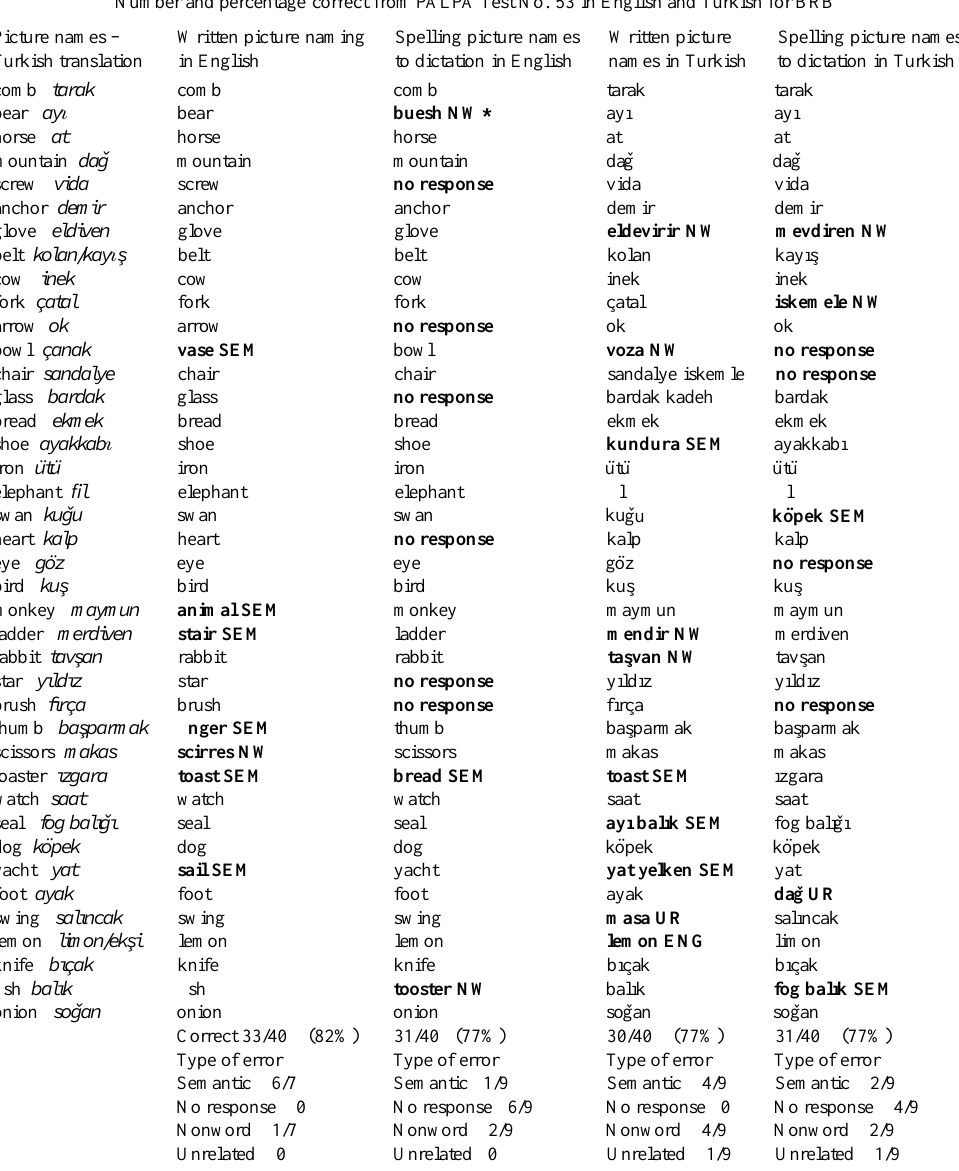
Table 3 Number and percentage correct from PALPA Test No. 53 in English and Turkish for